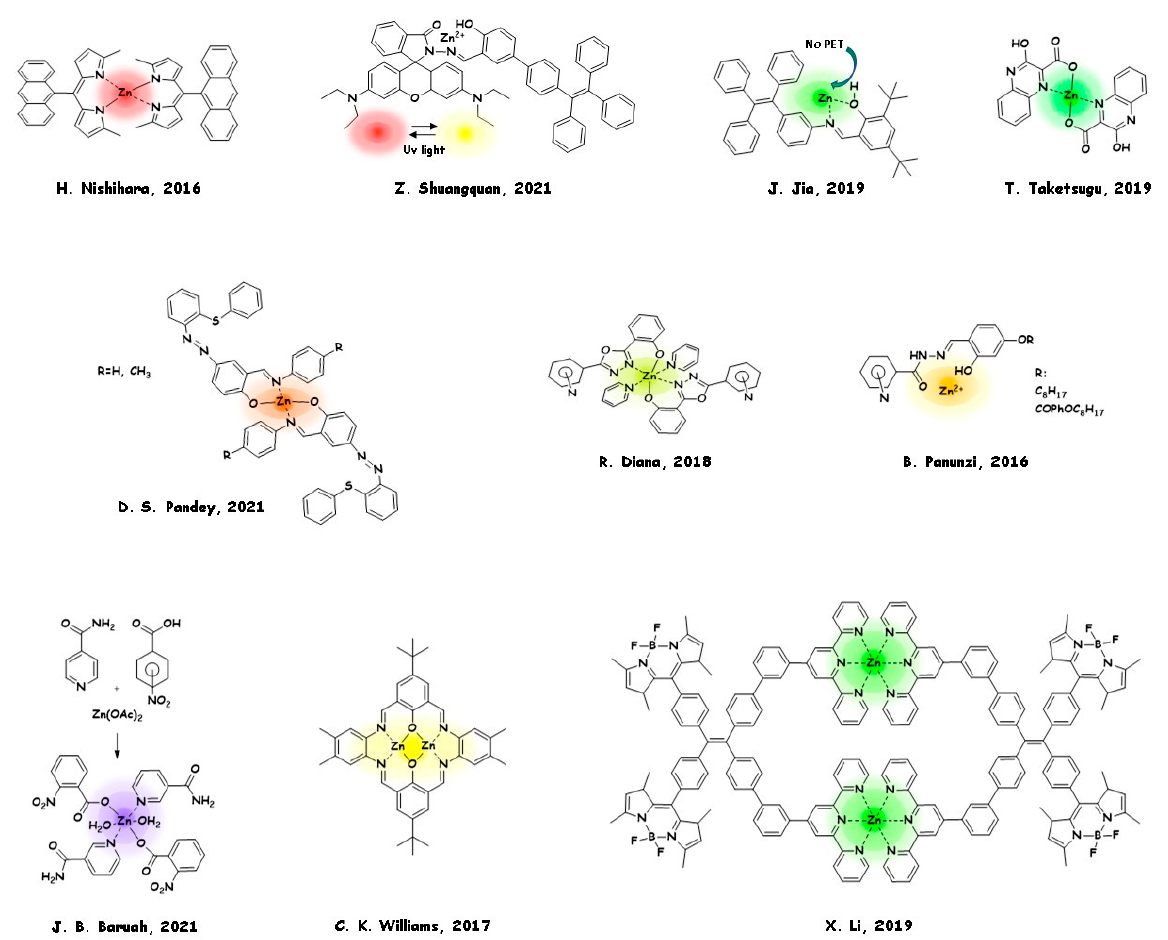
Figure 1. Zn AIEgens obtained by encumbered nitrogen and/or oxygen-donor-based ligands.